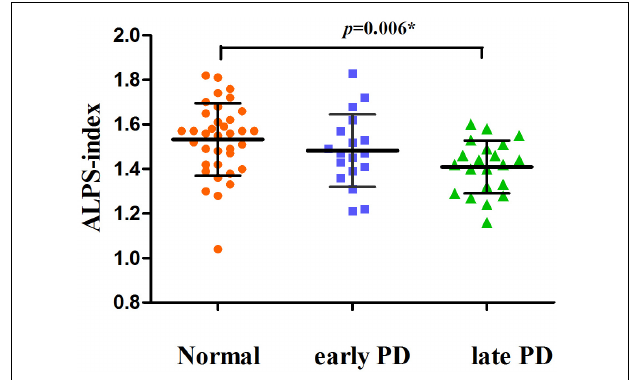
FIGURE 2 | Scatter plots showing the distribution of the ALPS-index values for normal controls, early and late PD subgroups. The p -value was obtained from the analysis of variance (ANOVA) post hoc